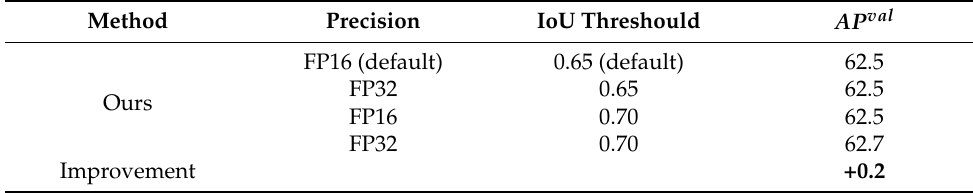
Table 4. Results of different precision and IoU